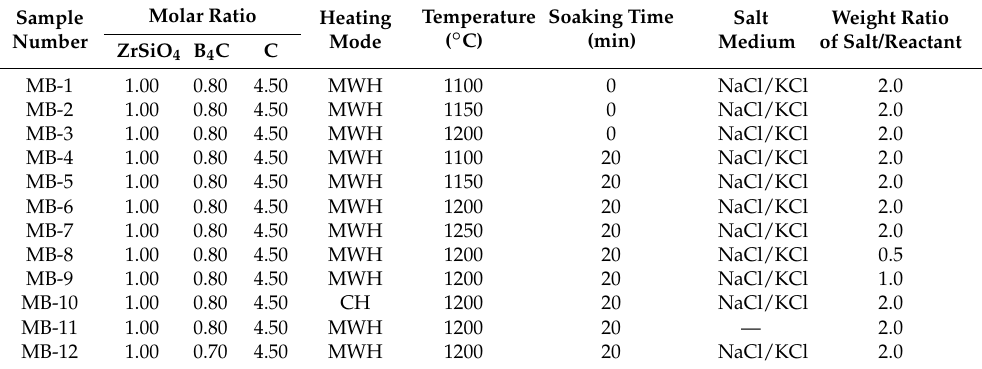
Table 1. Batch compositions and processing conditions for the preparation of ZrB 2 -SiC powders Sample